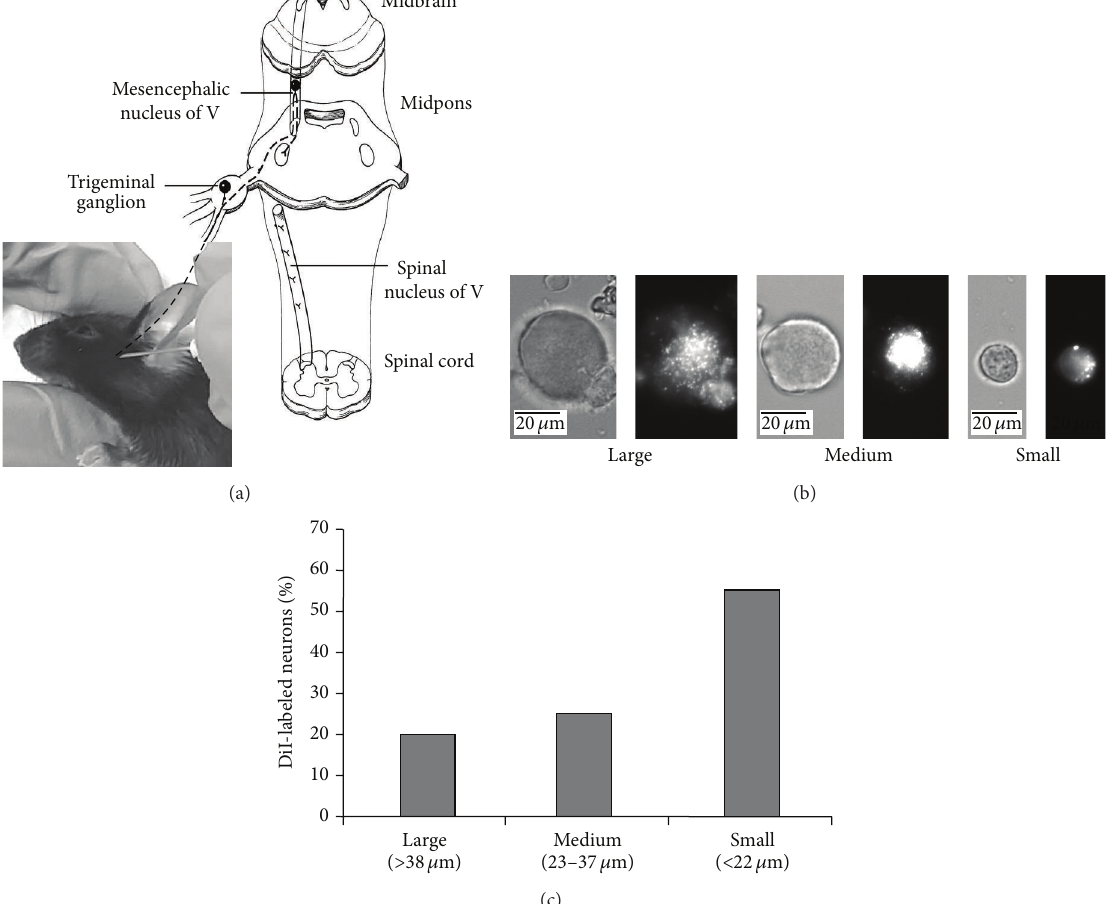
Figure 1: Verification of DiI-labeled trigeminal primary afferent neurons. (a) Retrograde labeling of trigeminal primary afferent neurons by TMJ injection with the fluorescent dye DiI. (b) Identification of DiI-labeled dissociated TG neurons. As illustrated, the representative large, medium, and small neurons are visualized under phase-contrast (left), and fluorescent (right) images, respectively. (c) The proportion of DiI-labeled dissociated TG neurons by